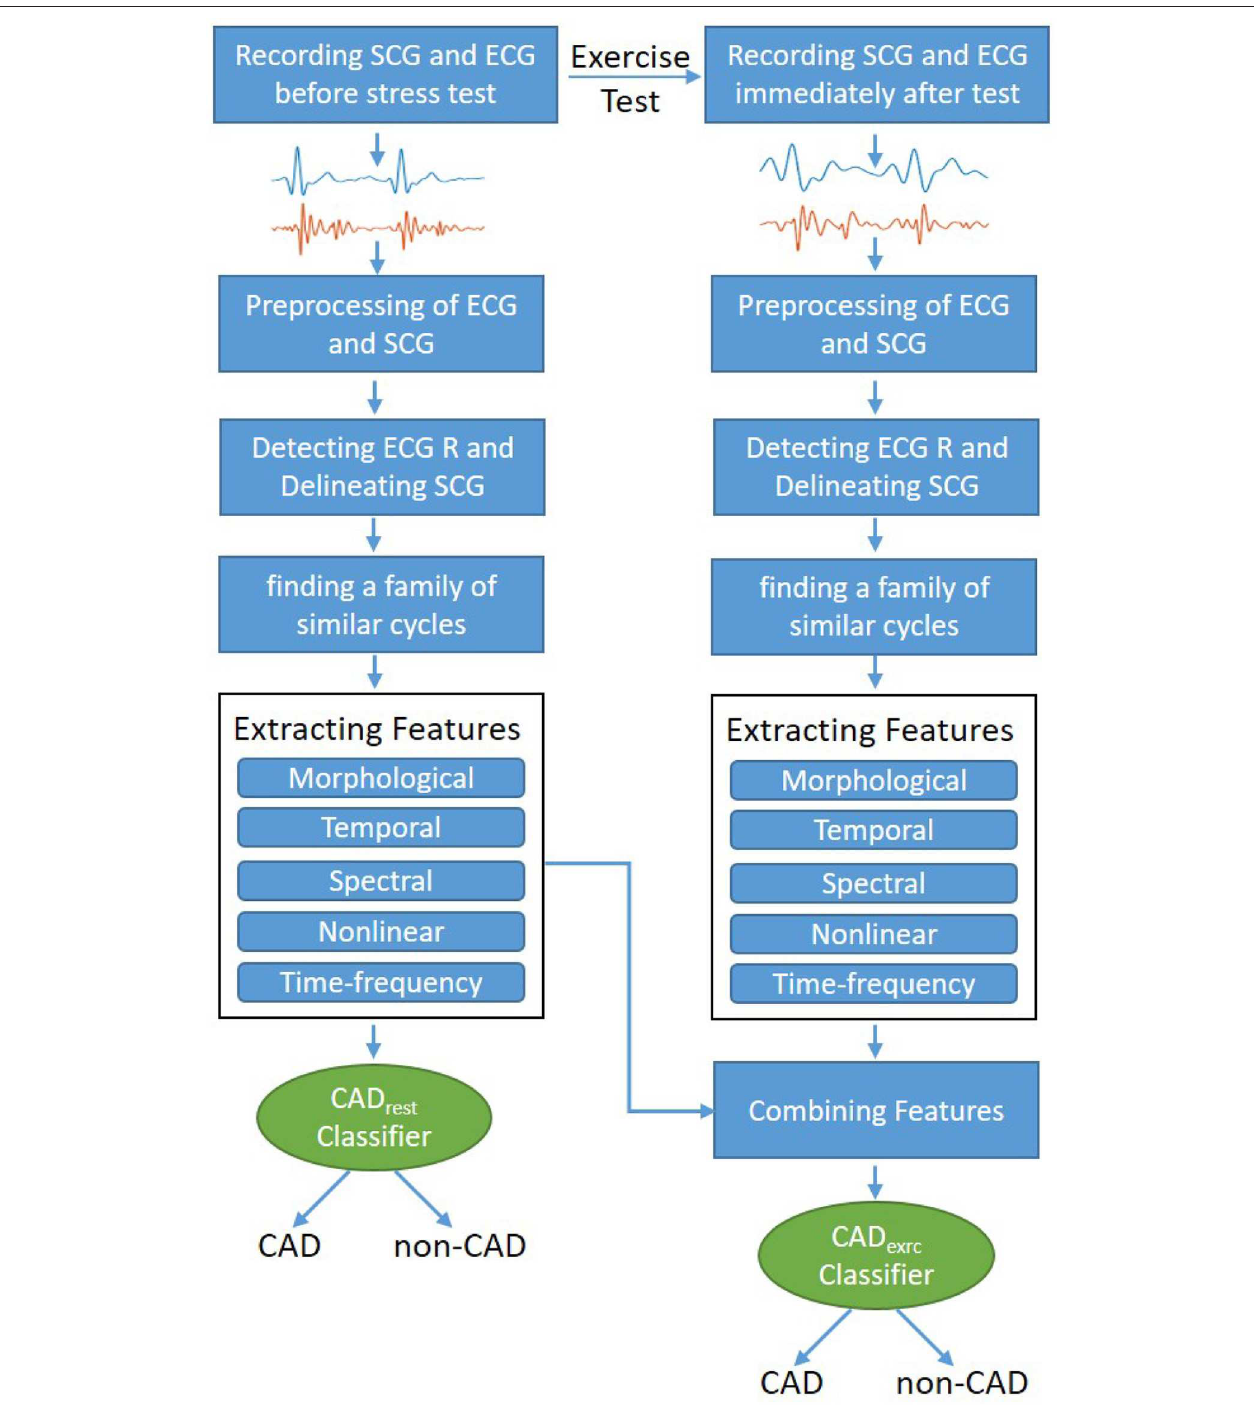
FIGURE 1 | Different steps of methodology designed and developed to identify patients with CAD from control group.